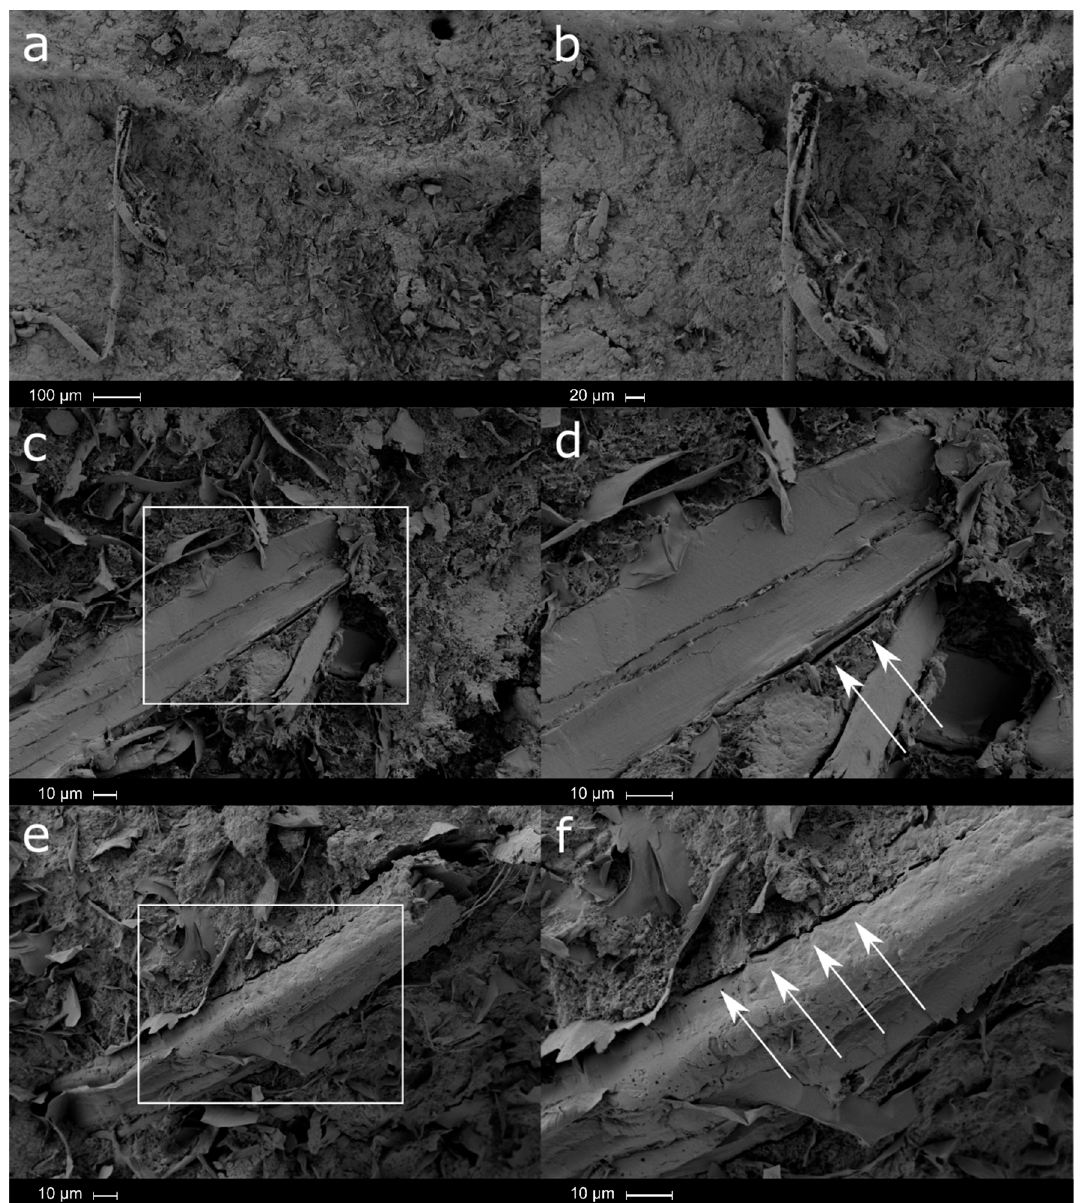
Figure 10. SEM micrographs of smallest particles, CB120—10 wt.% wood flour: ( a ) ×100, ( b ) ×200; CB120—20 wt.% wood flour: ( c ) ×500, ( d ) ×1000; and CB120—30 wt.% wood flour: ( e ) ×500, ( f ) ×1000.